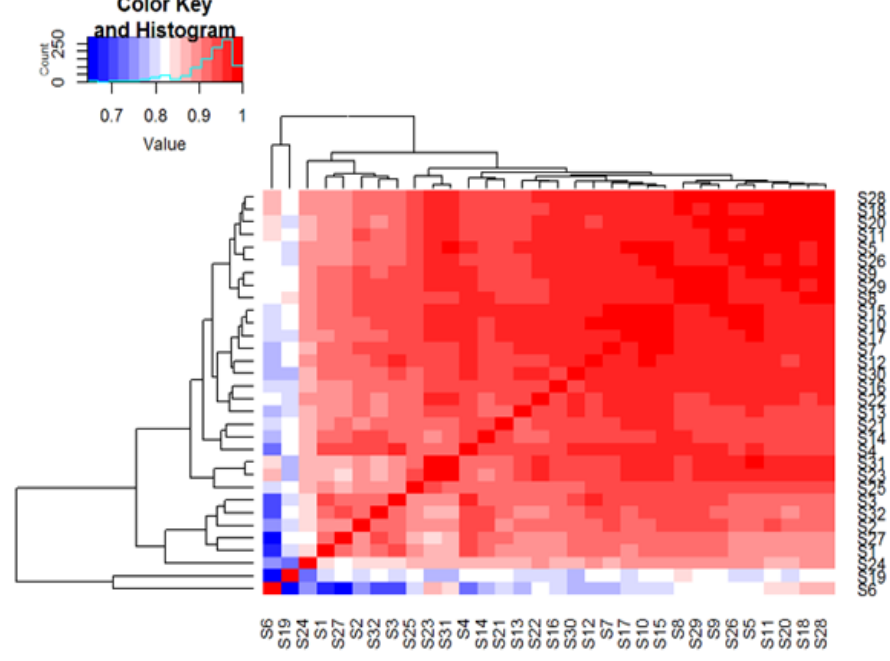
Figure 1. Association between sensors. Spearman correlation of sensors. Sensors are depicted on both the X-axis and Y-axis. A strong positive correlation is seen amongst the majority of sensors. A sensor output heatmap is depicted in Figure 2. There was a clear separation between samples measured on the first two dates and samples measured on the second two dates, irrespective of their disease state, disease activity state, disease localization and diet